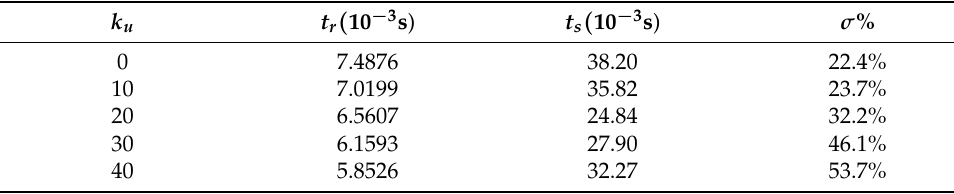
Figure 5. Comparison of HT control effect. Table 1. Comparison of HT control indicators.